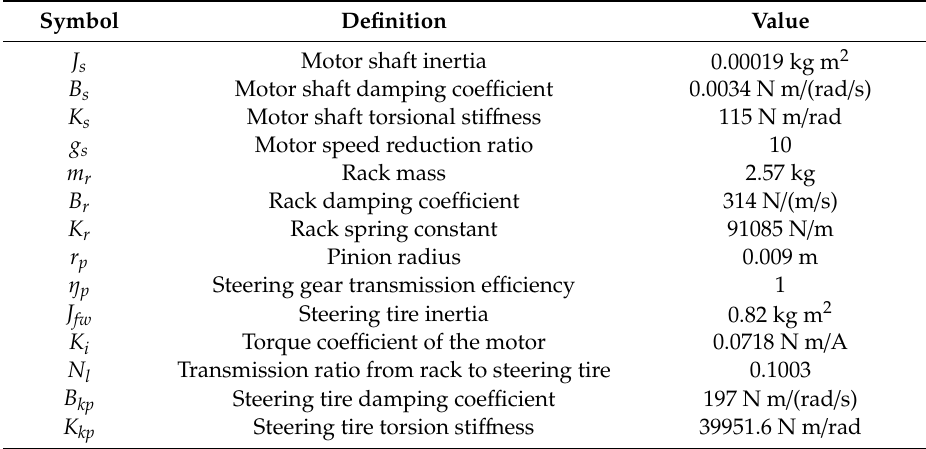
Table 3. Parameters of the SBW model.